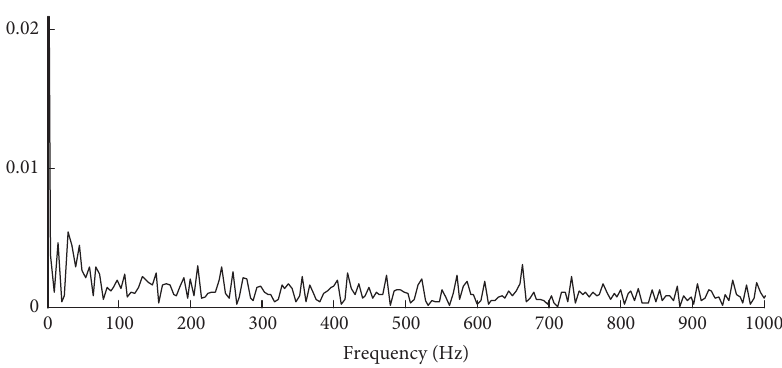
Figure 14: Envelope spectrum of low resonance component of inner race